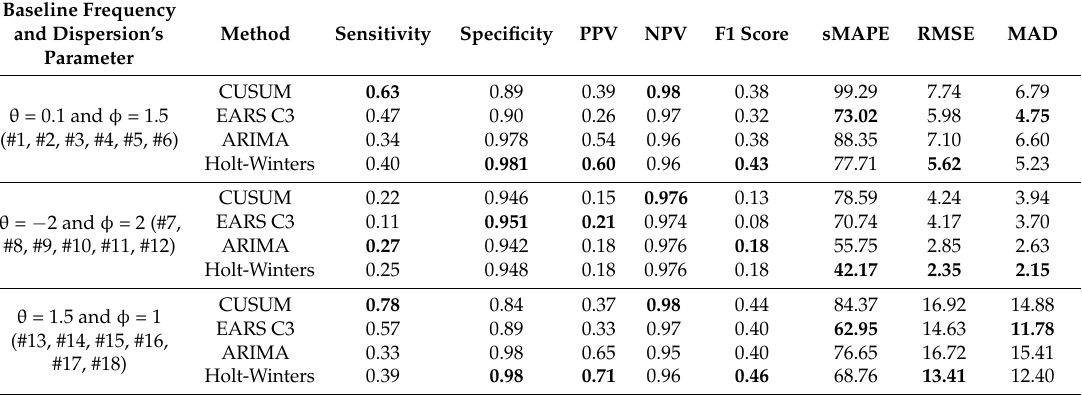
Table 2. The comparison of average performances for each baseline frequency and dispersion parameter. Baseline Frequency and Dispersion’s